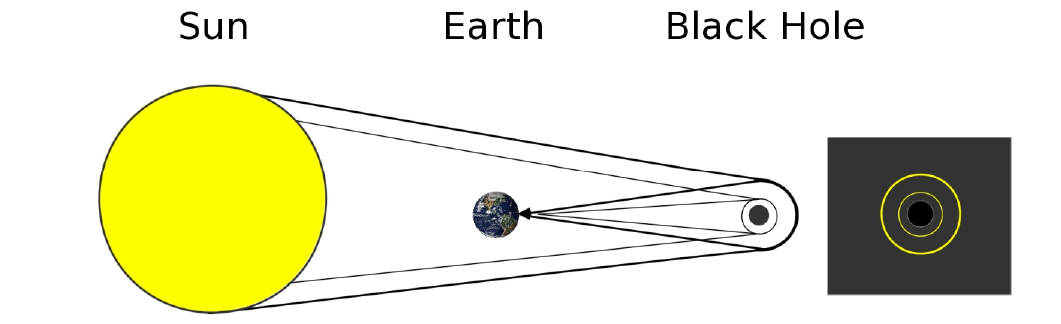
Figure 8. Retro-lensing of the Sun light by a black hole as seen from Earth. On the right-hand side, the series of rings around the black hole’s event horizon an observer would observe in the case of perfect alignment. For clarity, only two rings are